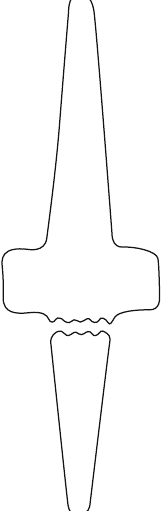
Figure 2: Swanson fi nger implant with metal grommets.